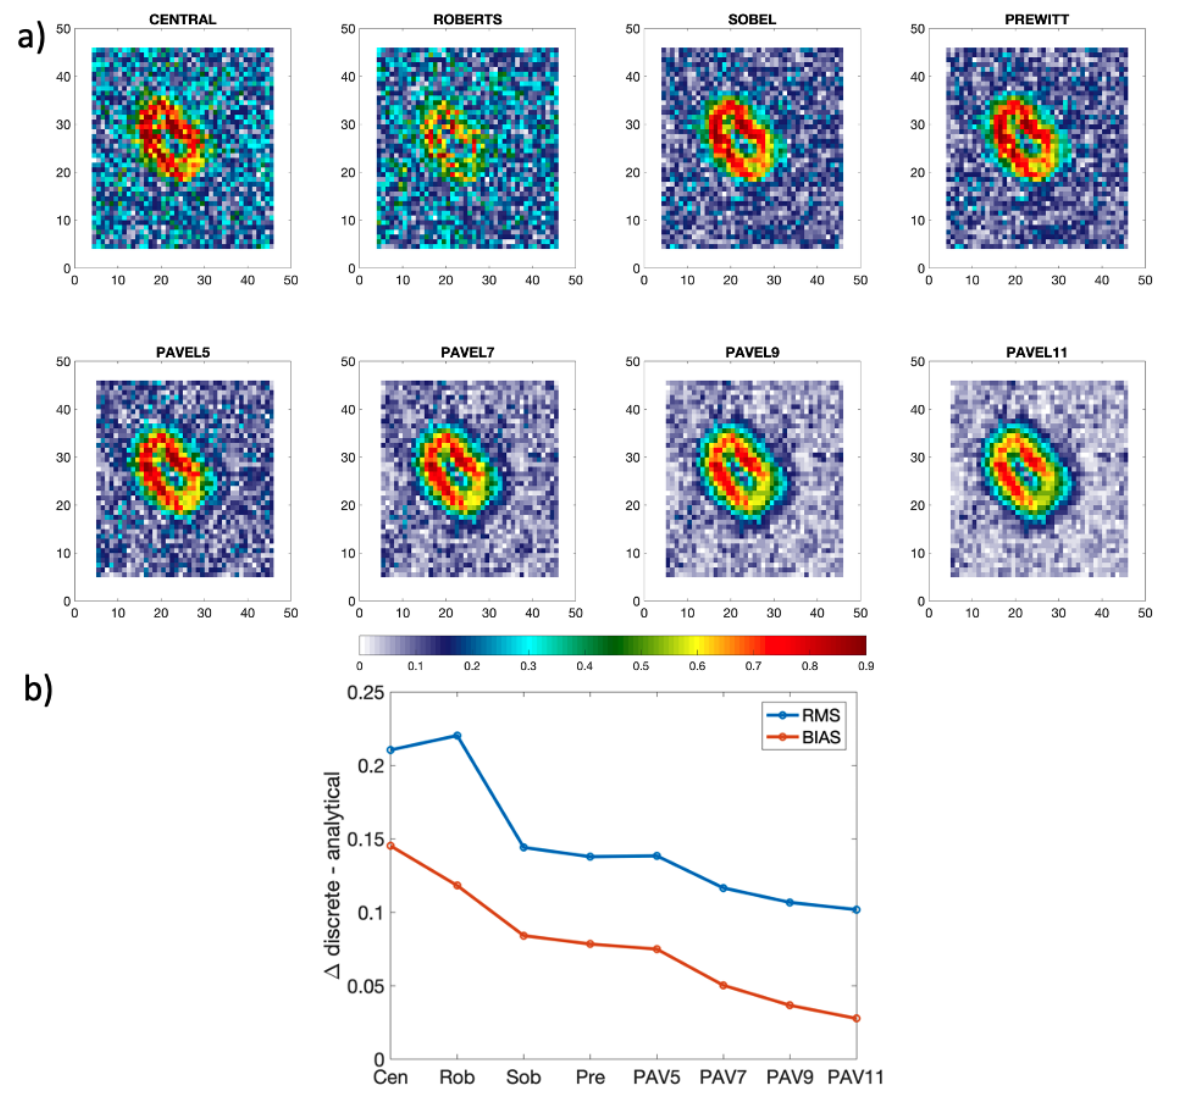
Figure 12. ( a ) Gradient intensities computed numerically using central, Roberts, Sobel, Prewitt and Pavel5 to 11 schemes. ( b ) RMSE (blue) and bias (orange) of the numerically computed gradient with respect to the analytical ground truth value calculated from the noise-free temperature field using Equation (3), units are in K. The analyses refer to an aSST field with addition of Gaussian noise with a zero mean and standard deviation of 0.15